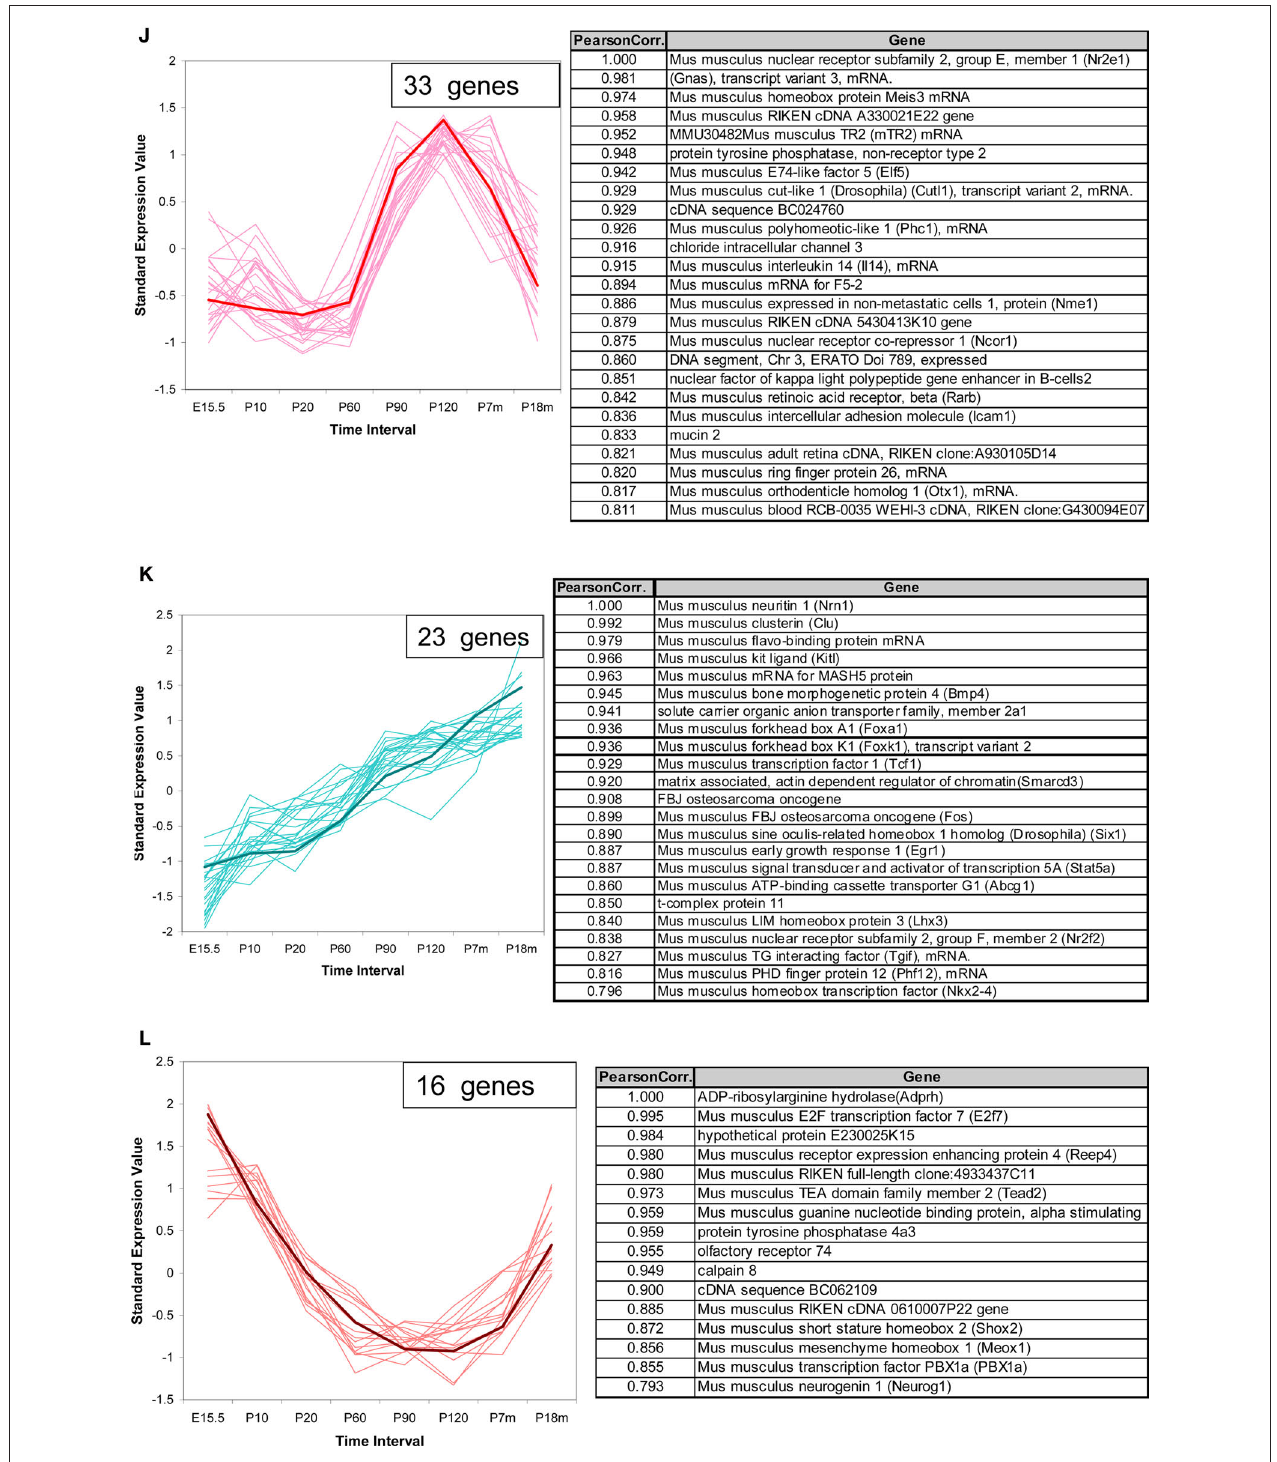
corresponding tables. A representative gene, which was selected based on the correlation to the average trend over time, is highlighted in the weighted line. The number of genes in each pattern is given in the box in the upper-left corner. The patterns are ordered in terms of the number of genes in the pattern except pattern (C) . In the table, the genes were ordered according to their correlation with the representative